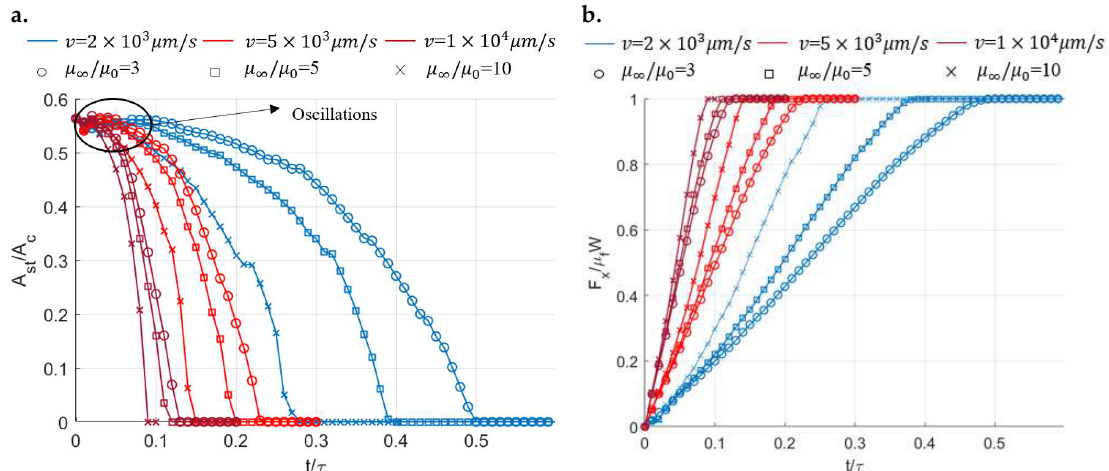
Figure 23. Simulation results under semi-coupled conditions: ( a ) Evolution of the stick ratio with time for different viscoelastic materials and ( b ) Evolution of the resulting tangential loads with time for different viscoelastic materials ( v is the increasing rate of tangential displacement).